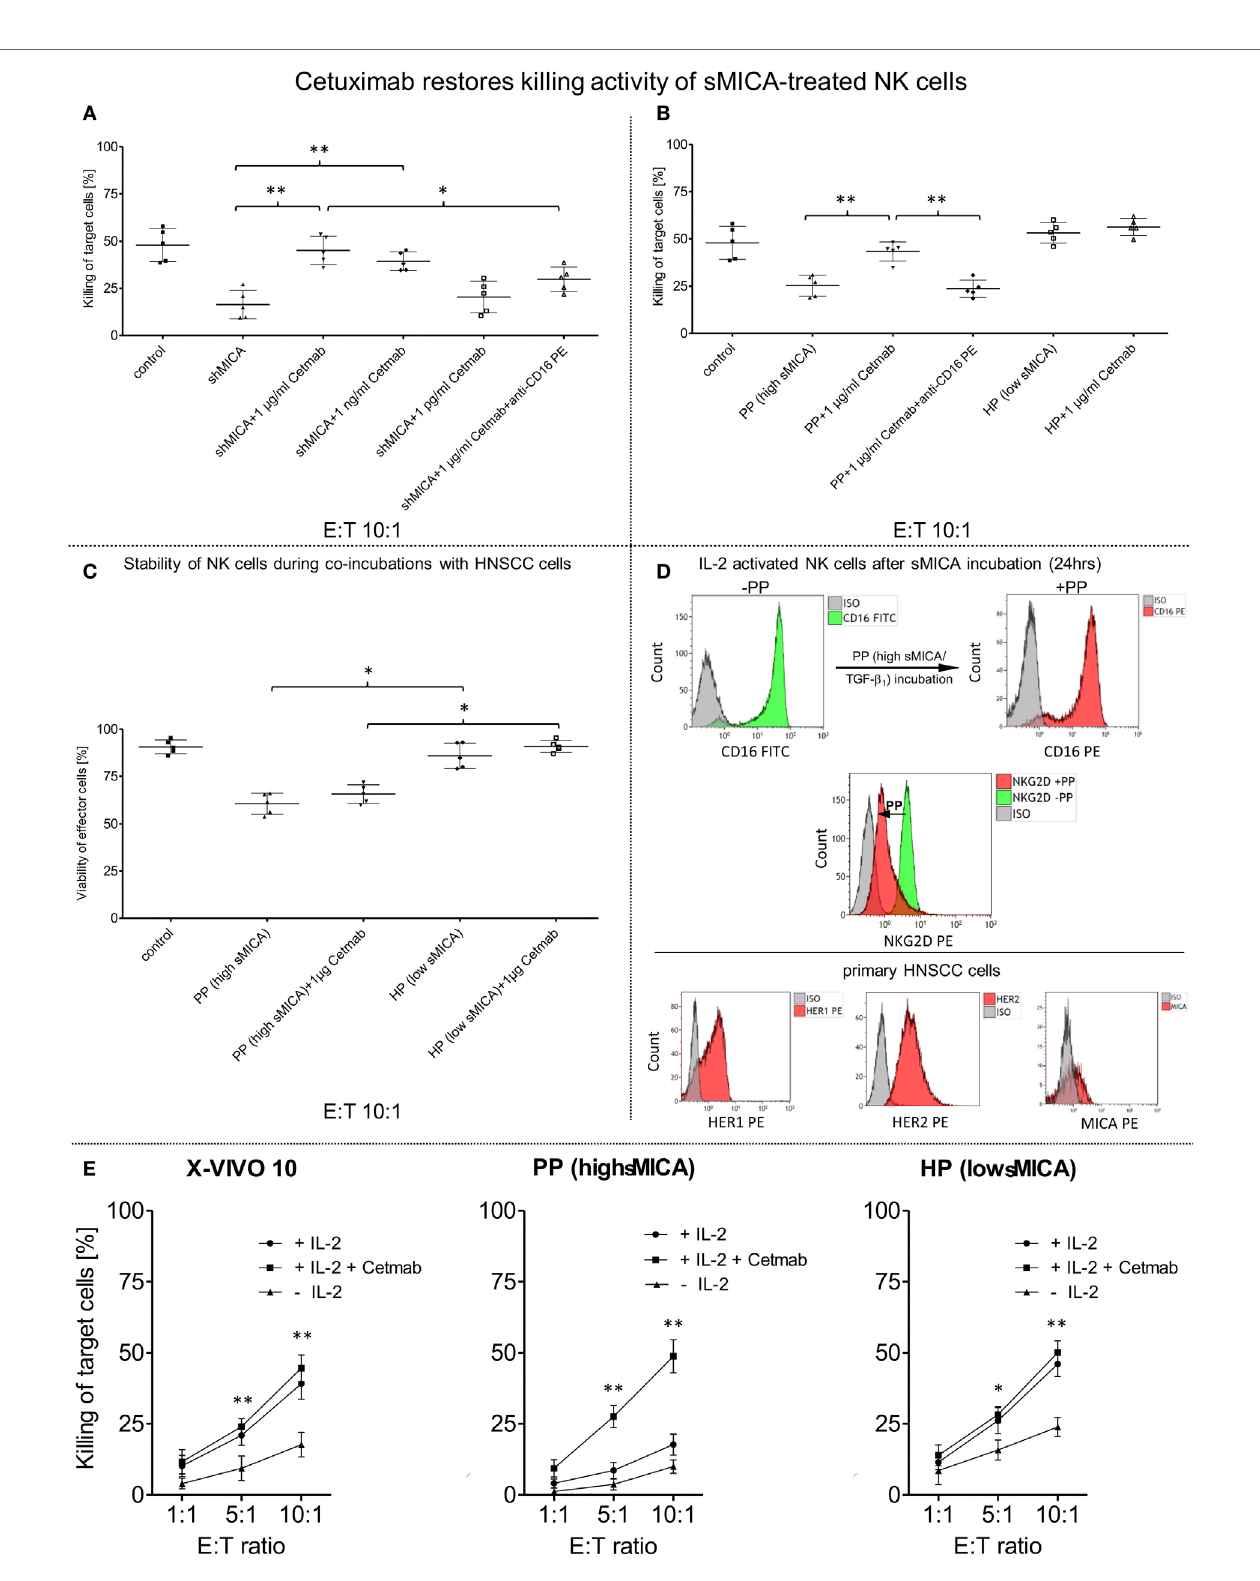
FigUre 4 | restored killing activity against primary hnscc cells mediated by cetuximab